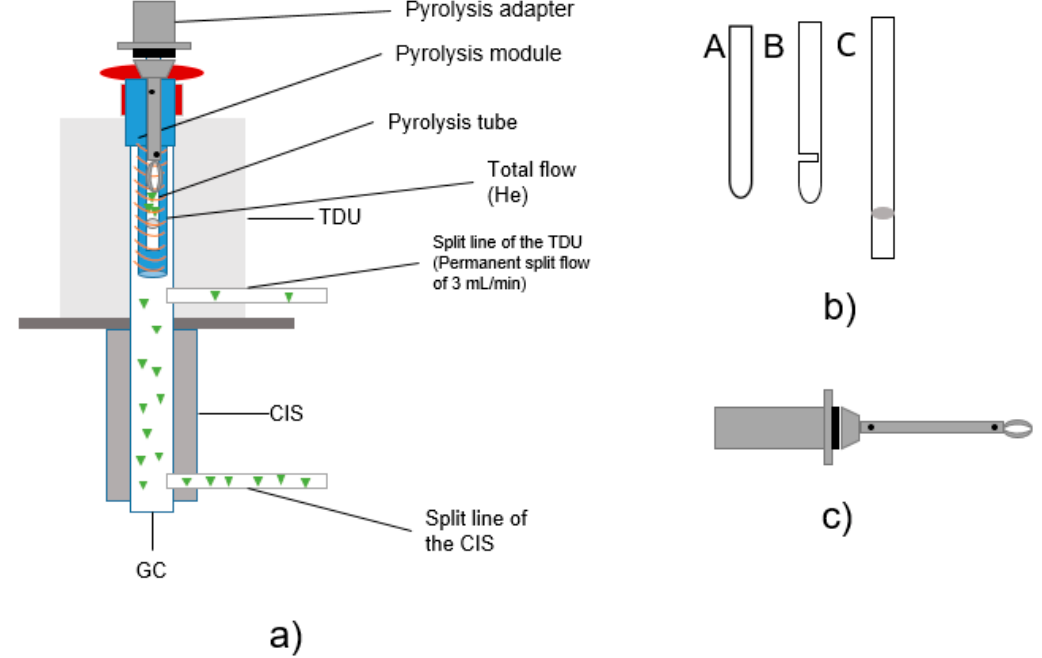
Figure 2. ( a ) Structure TD-GC/MS + Pyr-GC/MS; ( b ) design of different pyrolysis tubes (sample tubes); ( c ) drawing of pyrolysis transport adapter.